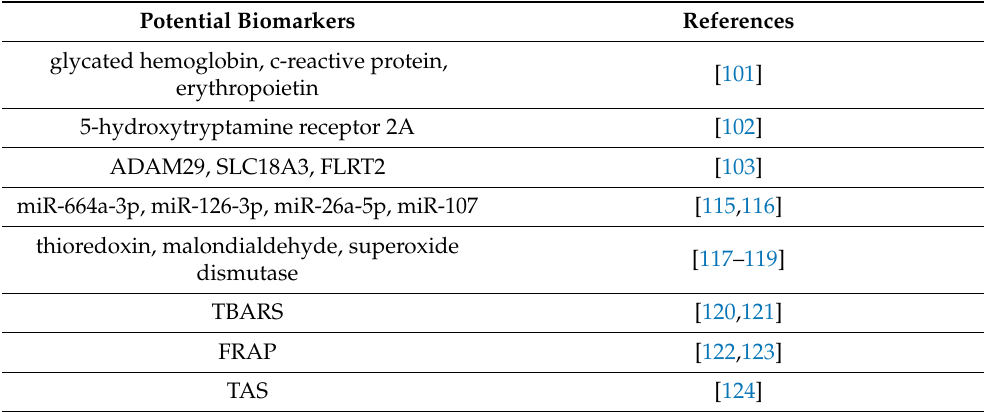
Table 1. Potential OSAS diagnostic biomarkers. Clinical validations are needed. Potential